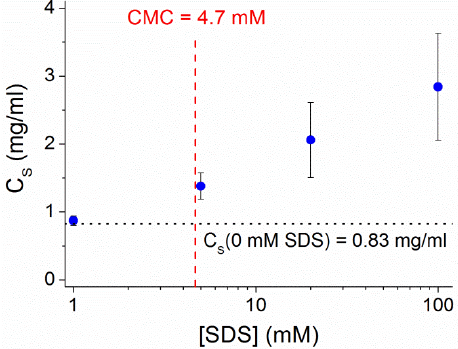
Figure 13. Apparent solubility limit C S of Ibp as a function of SDS concentration in 5 mM PBS, measured from single microdroplets and determined by using the Epstein-Plesset model. A constant diffusion coefficient for Ibp was assumed, D = 5.5 × 10 −6 cm 2 /s, obtained at 0 mM SDS, at which the solubility limit of Ibp was experimentally determined to be 4 mM = 0.82 mg/mL [77]. Mean and standard deviation for at least three different droplets are indicated.